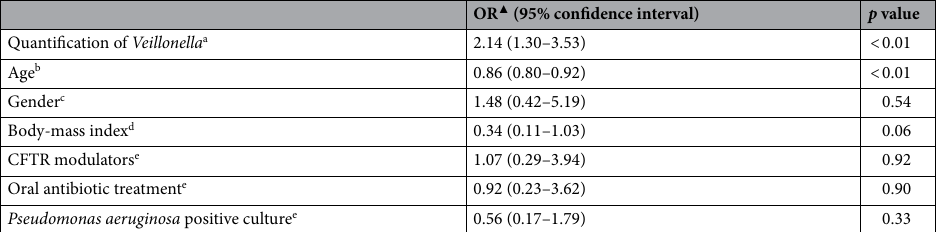
Table 2. Multivariate analysis: logistic regression modelling the probability of Forced Expiratory Volume in one second (FEV 1 ) > 70%. a Odds-ratio relative to a one-log increase. b Odds-ratio relative to a one-year increase. c Woman versus man. d < 18.5 kg/m 2 versus > 18.5 kg/m 2 . e Yes versus